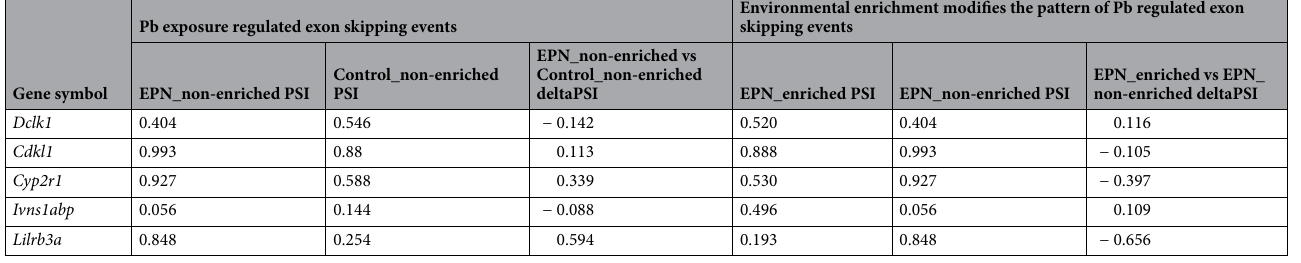
Table 3. Environmental enrichment modifies Pb exposure-induced exon skipping events. PSI Percent Spliced In, deltaPSI: PSI (EPN_non-enriched—Control_non-enriched) or PSI (EPN_enriched—EPN_non-enriched), EPN early postnatal Pb